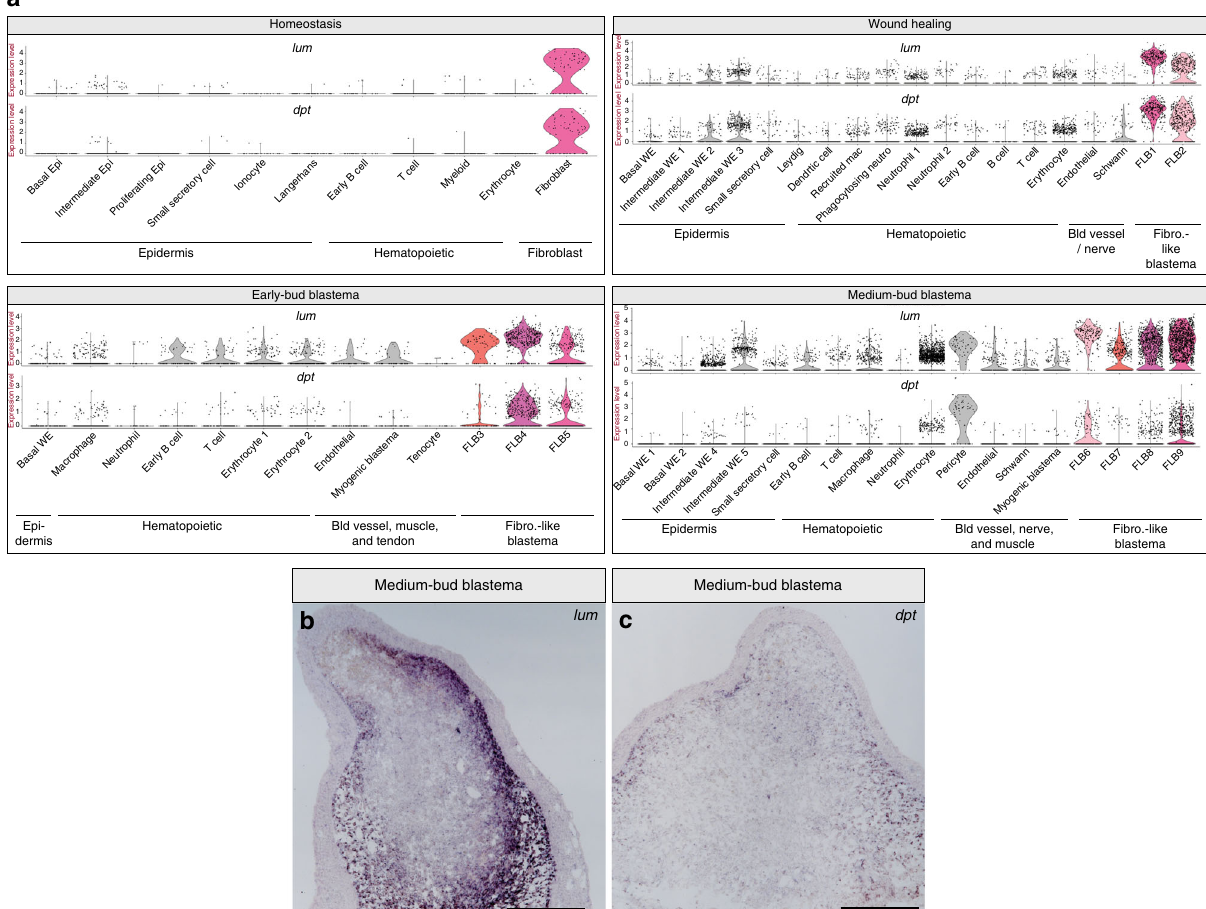
Fig. 6 Fibroblasts-like cells are found during homeostasis and regeneration. a Violin plots depicting log 2 values of normalized expression of fi broblast and fi broblast-like blastema (FLB) cell-enriched genes lum and dpt at homeostasis, wound healing, early-bud blastema, and medium-bud blastema stages. Each dot represents an individual cell; fi broblast/FLB populations of interest are depicted in color, while all other populations are in gray. b Representative RNA in situ hybridization probing for lum in a medium-bud blastema. c Representative RNA in situ hybridization probing for dpt in a medium-bud blastema. Magni fi cation ×4, scale bar is 500 μ m. n = 4 animals per points, including at homeostasis, that appear to be fi broblast-like cells. These fi broblast-like cells have high expression of lumican ( lum ), dermatopontin ( dpt ), and periostin ( postn ), which in mice are expressed by fi broblasts and periosteal cells 51 – 53 (Fig. 6a,